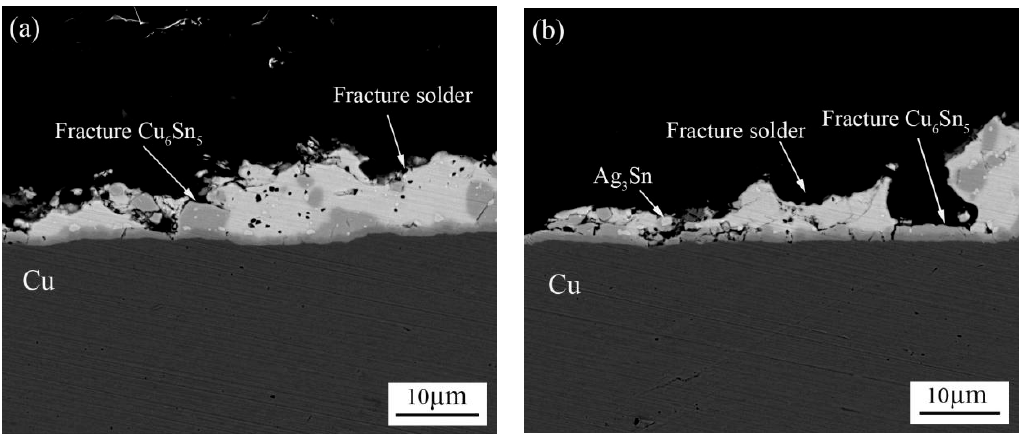
Figure 7. Top views of the shear fracture surfaces for the solder joints at 800-ms ultrasonic bonding times for different aging time: ( a ) 24 h; ( b ) 120 h; ( c ) 240 h and ( d ) 360 h. Materials 2018 , 11 , 84